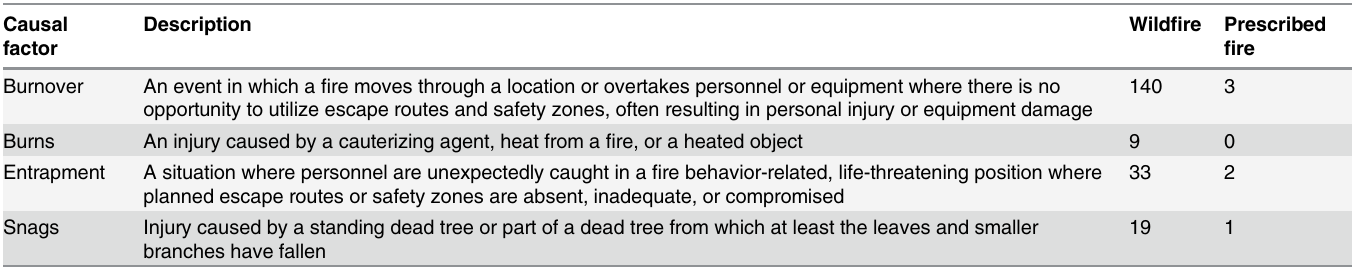
Table 2. Comparison of causal factors associated with fire and the post-fire environment accounting for fatality rates in prescribed fires and wild- fires from 1963 –